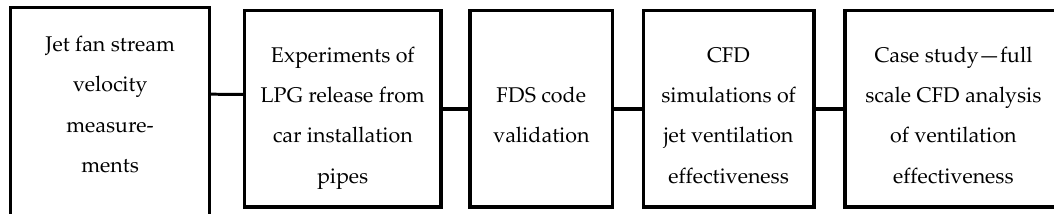
Figure 2. Steps in the analysis process. FDS: Fire Dynamics Simulator; CFD: computational fluid dynamics.